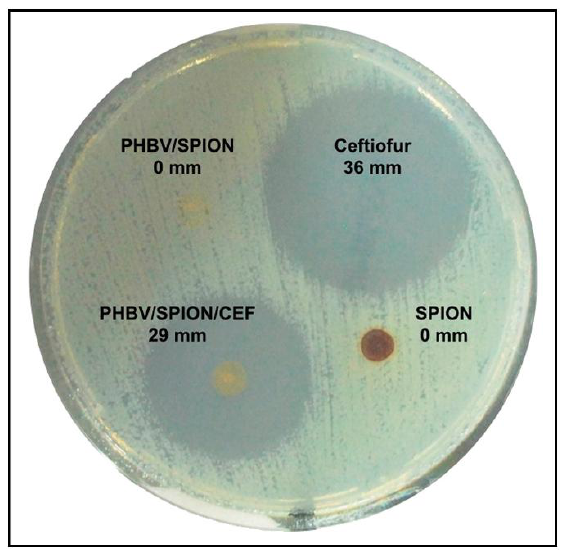
Figure 5. Determination of the antimicrobial activity of PHBV nanoparticles, ceftiofur and superparamagnetic iron oxide nanoparticles (SPIONs) against Escherichia coli (ATCC 25922) through the agar diffusion test at 24 h of incubation. Reproduced with permission from Ref. [174] .